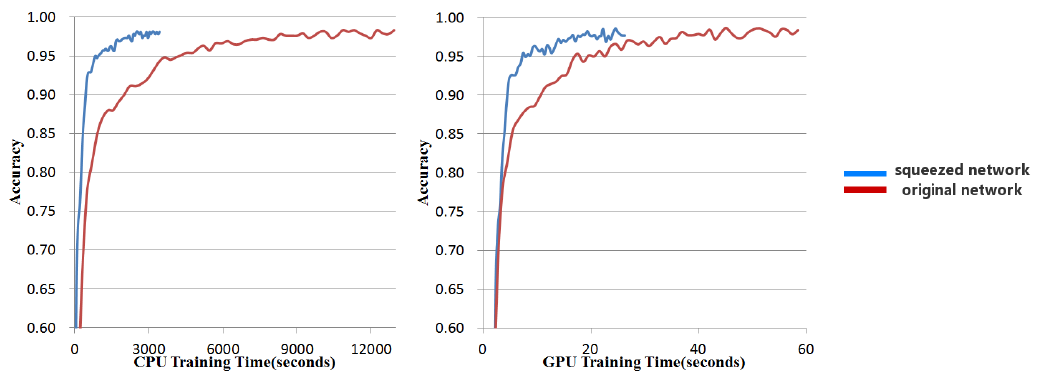
Figure 10. Training time of original network and squeezed network in CPU and